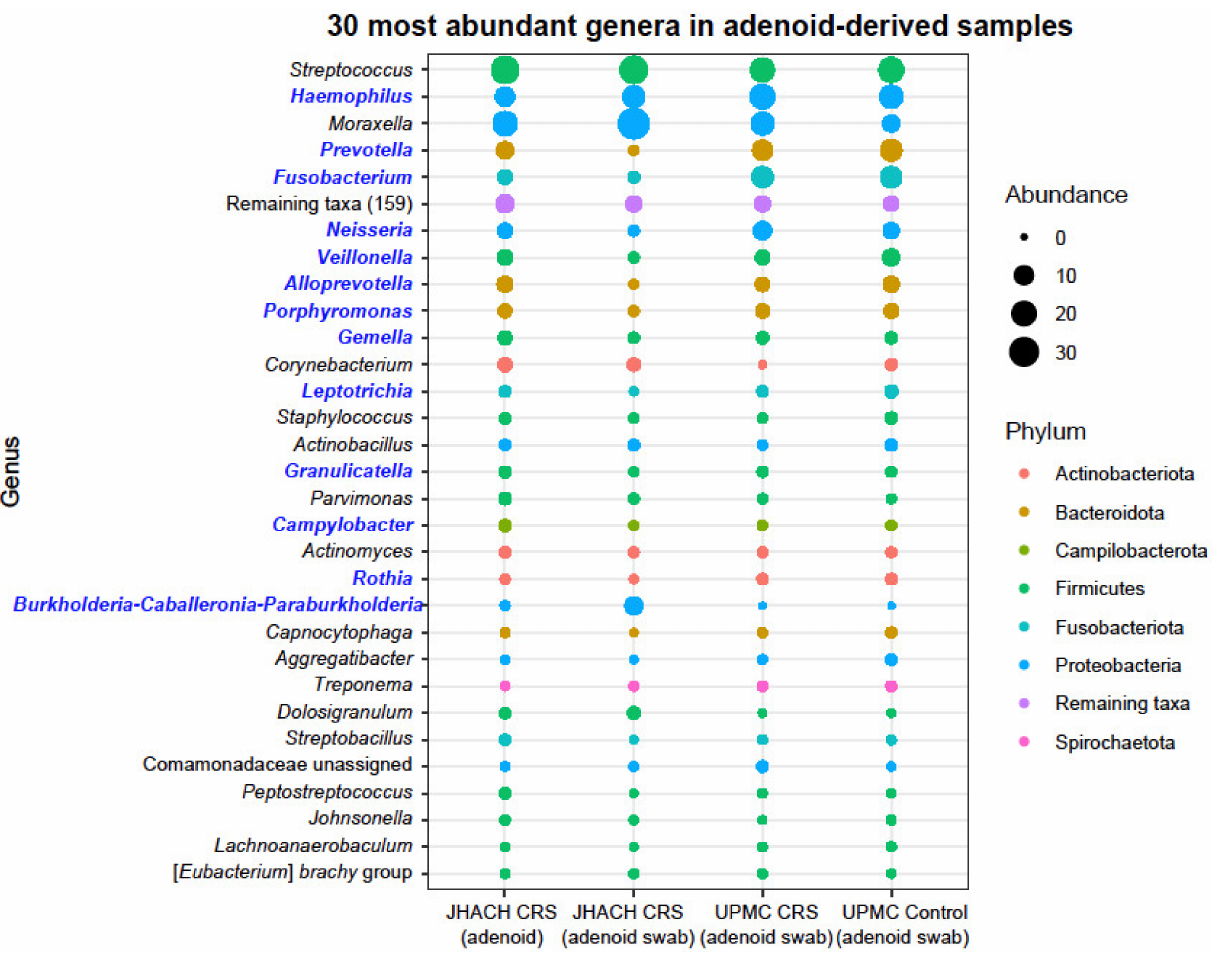
Figure 5. Mean abundances of the 30 most abundant genera in adenoid-derived samples from chronic rhinosinusitis (CRS) and healthy participants in the Johns Hopkins All Children’s Hospital (JHACH) and/or University of Pittsburgh Medical Center (UPMC) cohorts. Differentially abundant genera across sample subgroups are indicated in